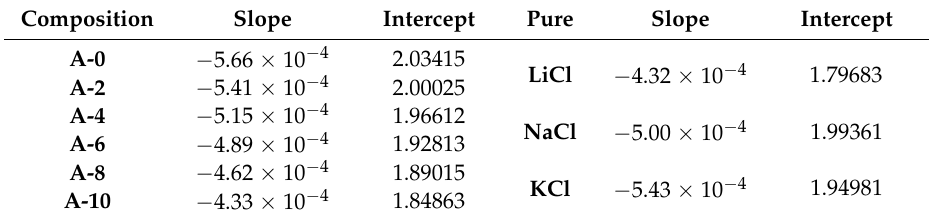
Table 4. Linear fit of the simulated density for six typical systems (900 K–1200